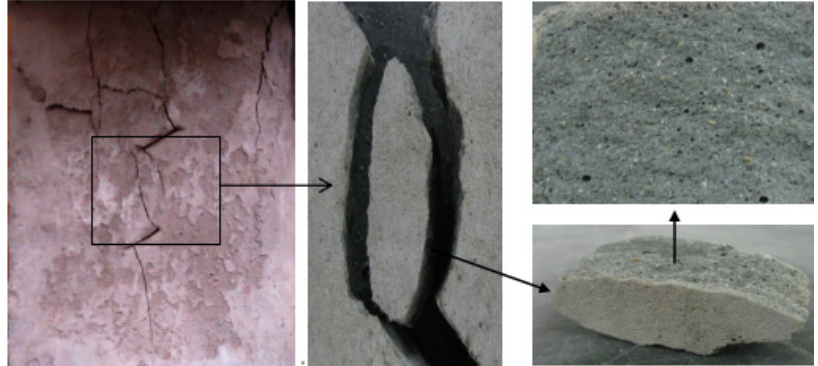
Figure 4. Wing crack propagation failure and its pattern.